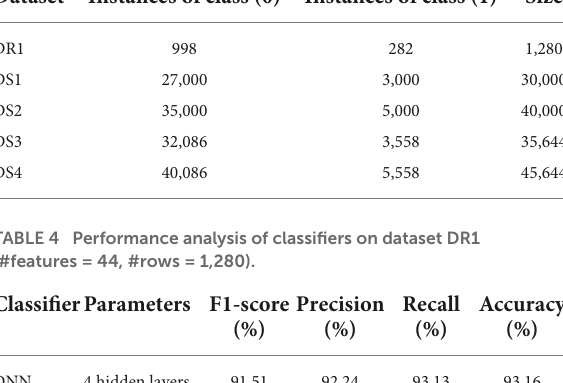
TABLE 3 Description of datasets used in this research.